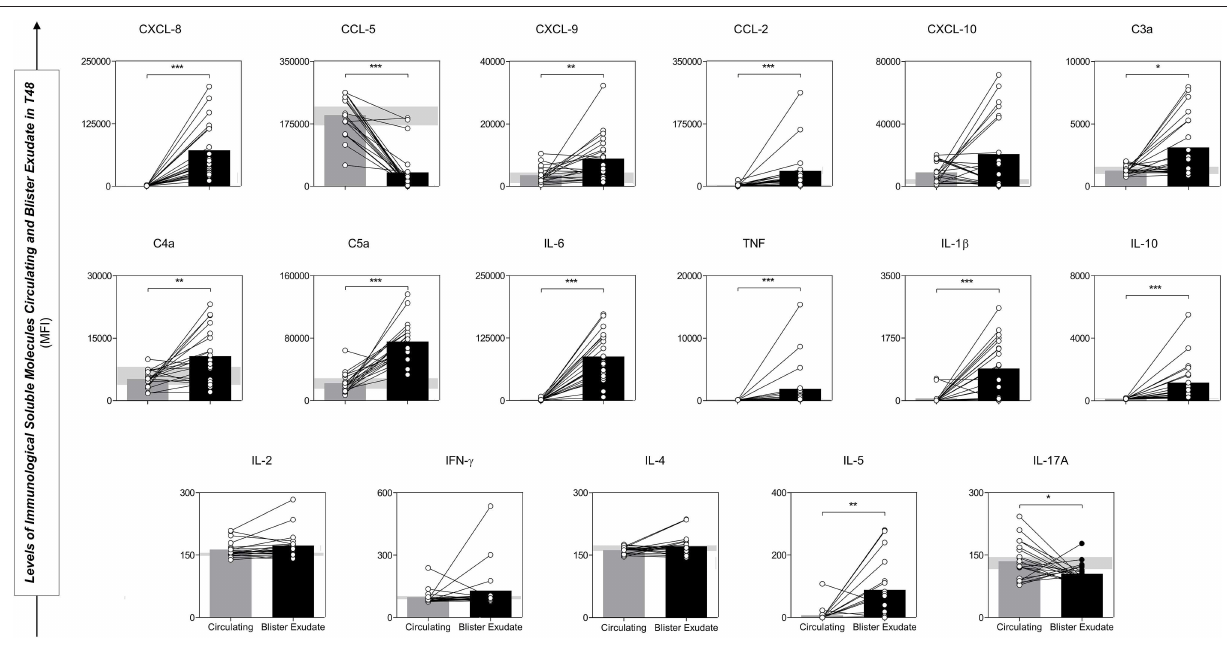
FIGURE 6 | Comparative analysis of Immunological Soluble Molecules circulating and blister exudate paired samples from STC patients illustrated the production profile and concentration in the different environments. Values of p < 0.05. * p < 0.05; ** p < 0.01; *** p < 0.0001 were considered significant. Immunological Soluble Molecules Level Quantification by CBA and ELISA. Data are expressed as mean ± standard deviation in MFI for Immunological Soluble Molecules. Statistical analyses were performed using the Mann-Whitney